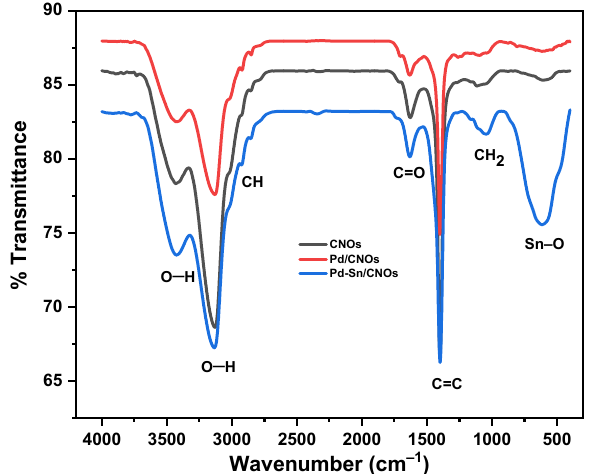
Figure 4. FTIR spectra of carbon nano-onion (CNO) supports and Pd/CNO and Pd-Sn/CNO electro-catalysts.